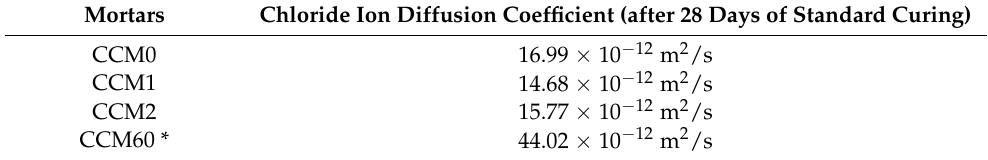
Table 9. Chloride ion diffusion coefficients of mortars.